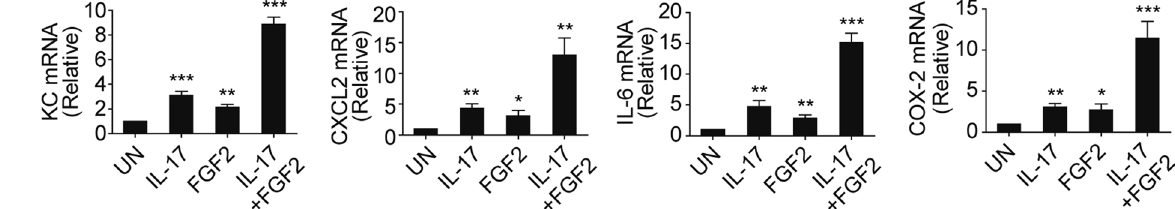
Figure 2. FGF2 synergizes with IL-17 to induce pro-inflammatory gene production. Quantitative mRNA expression of KC, CXCL2, IL-6 and COX-2 in human primary FLS cells left untreated (UN) or stimulated for